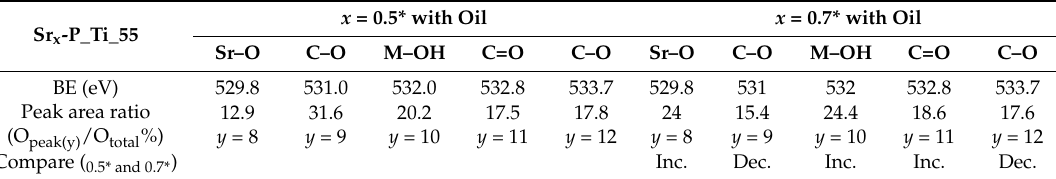
Table 2. Taking the area ratios of O-related peaks (deconvoluted) for the changes of SrO (in proportion to the quantity) and biodiesel (one of the products). Note that the area of oxygen peak = y, Increase = Inc., Decrease =